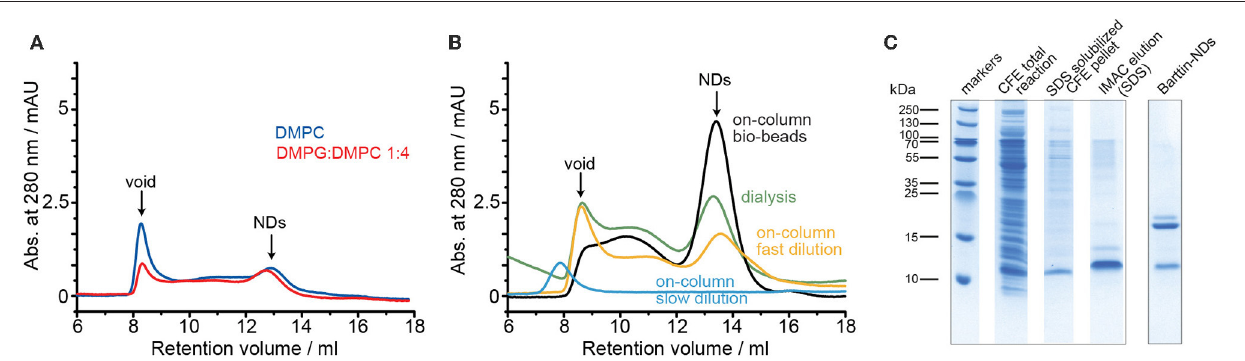
FIGURE 1 | Optimization of barttin reconstitution into D1 NDs. (A) SEC profiles of barttin NDs (MSP1D1) assembled with DMPC (blue) and DMPG:DMPC 1:4 (red) upon sodium cholate dialysis. (B) SEC chromatograms of barttin NDs (MSP1D1) assembled with DMPC upon detergent dialysis (green), on-column biobeads adsorption (black), on-column fast dilution (yellow), and on-column step dilution (blue). (C) Coomassie blue-stained SDS-PAGE of CFE expressed barttin (total reaction), solubilized CFE pellet, SDS- purified barttin and purified (IMAC, before SEC) barttin NDs (MSP1D1) assembled with DMPC upon on-column biobeads